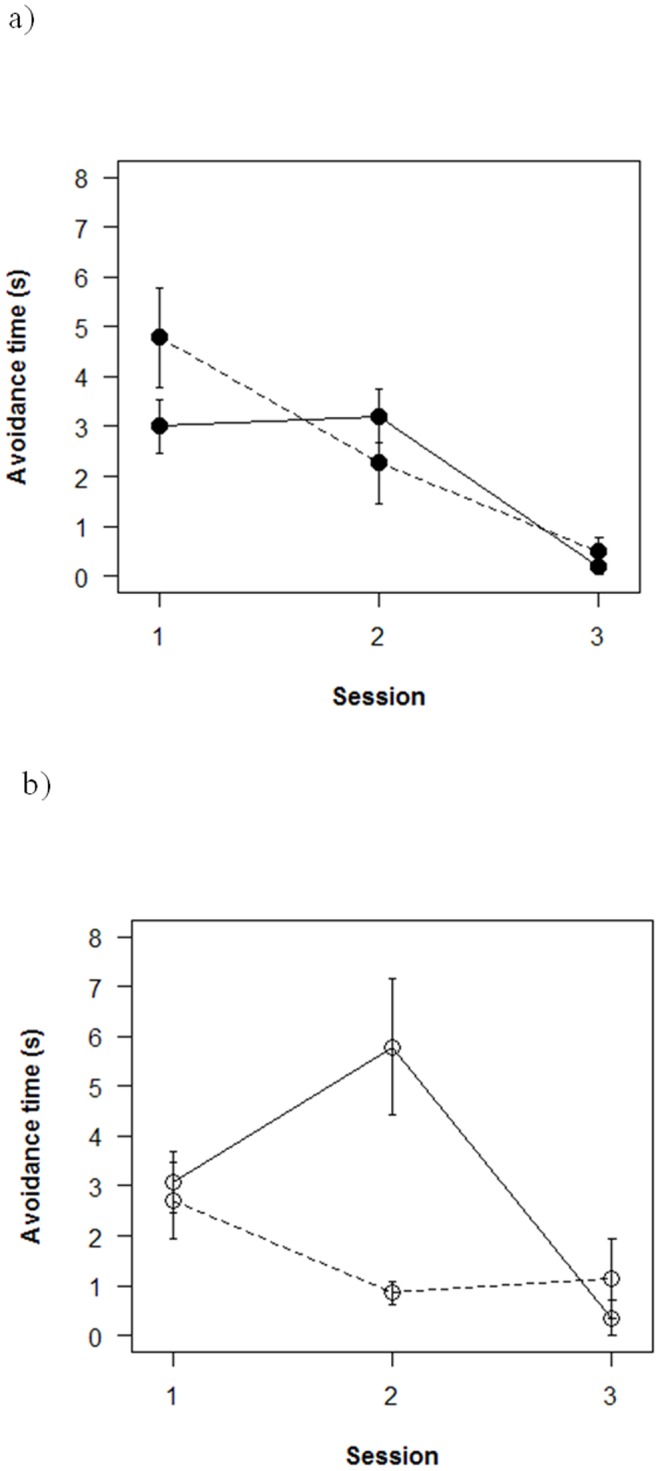
Individual zebrafish decreased escape time from an aversive stimulus across three sessions.2a) Female SH zebrafish (dashed lines) decreased escape time by the second session, whereas female PN zebrafish (solid lines) generally took until the third session to evade effectively. 2b) Male zebrafish showed a steady improvement in response time regardless of strain, leading to a sex×strain interaction effect during the second training session. Error bars are one standard error.